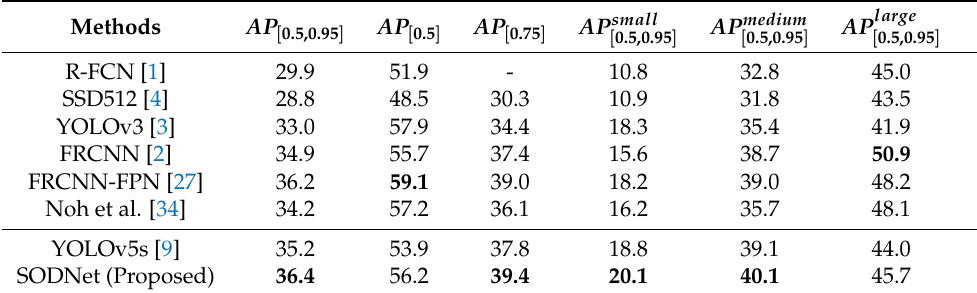
Table 6. Performance comparison with the proposed method and baseline on MS COCO 2017 test-dev dataset. The best results are marked in